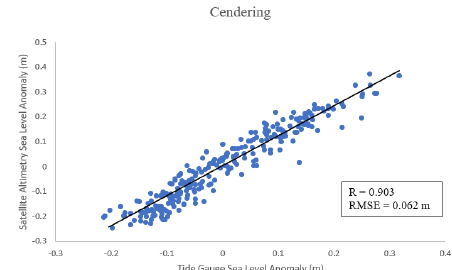
Figure 5. Correlation coefficient graph with a positive linear line indicates a good correlation between satellite altimetry and tide gauge